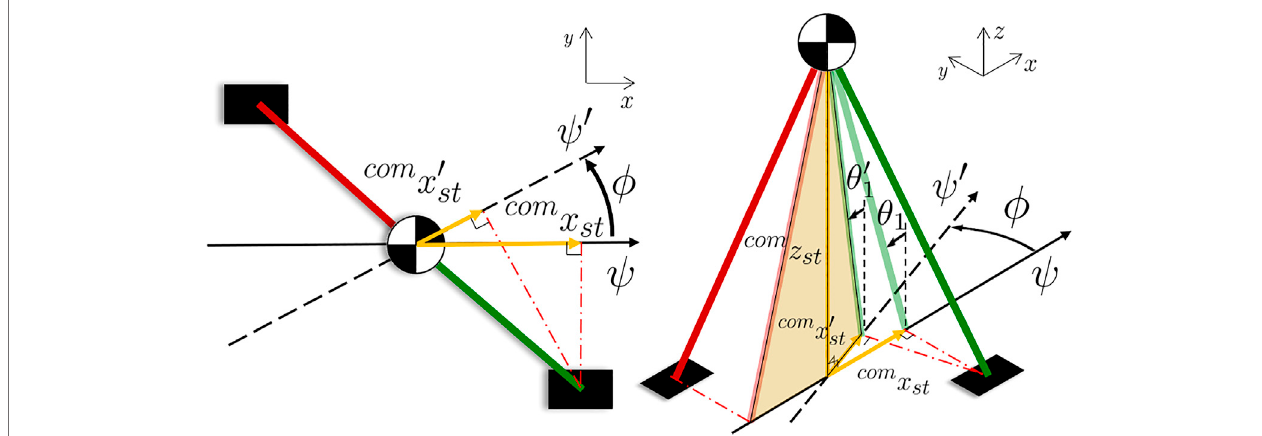
FIGURE 8 | Scheme of the compass model (left: xy-plane view, right: 3D space representation) during a steering step from the heading ψ to ψ ’ . The sagittal plane rotates of ϕ : the distance between the stance ankle and the CoM decrease, since the ankle position is projected on the new plane. Consequently, the tilt angle θ 1 changes and the new θ 1 ’ must be computed.